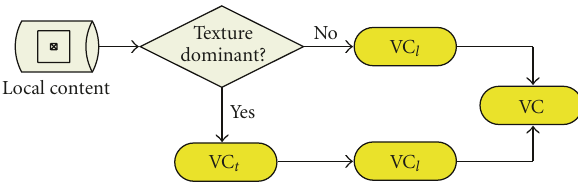
Figure 9: Integration strategy of the texture and luminance masking e ff ect.